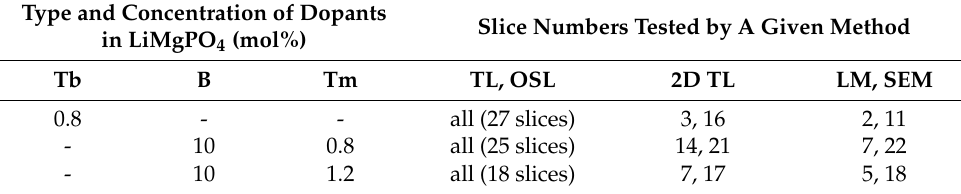
Table 1. Chemical composition and concentration of dopants of lithium magnesium phosphate (LMP) crystals and slice numbers tested by a given